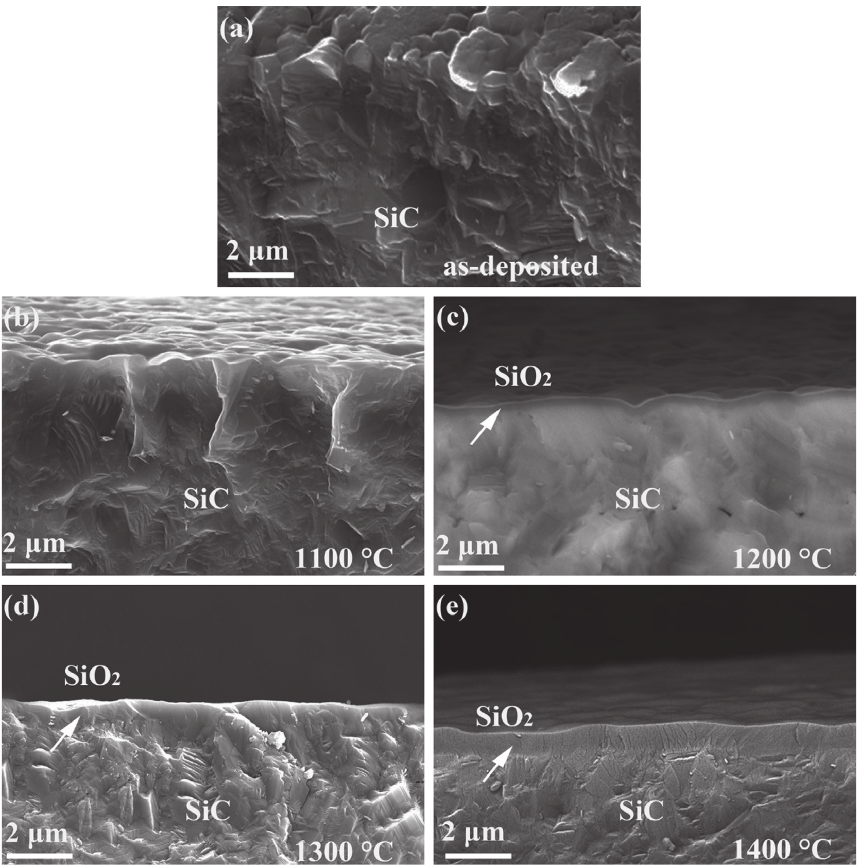
Figure 3: The fracture cross-section SEM morphology of the SiC layers of (a) as-deposited and after exposure in air at a temperature of (b) 1100 ° C, (c) 1200 ° C, (d) 1300 ° C, and (e) 1400 ° C for 24h.